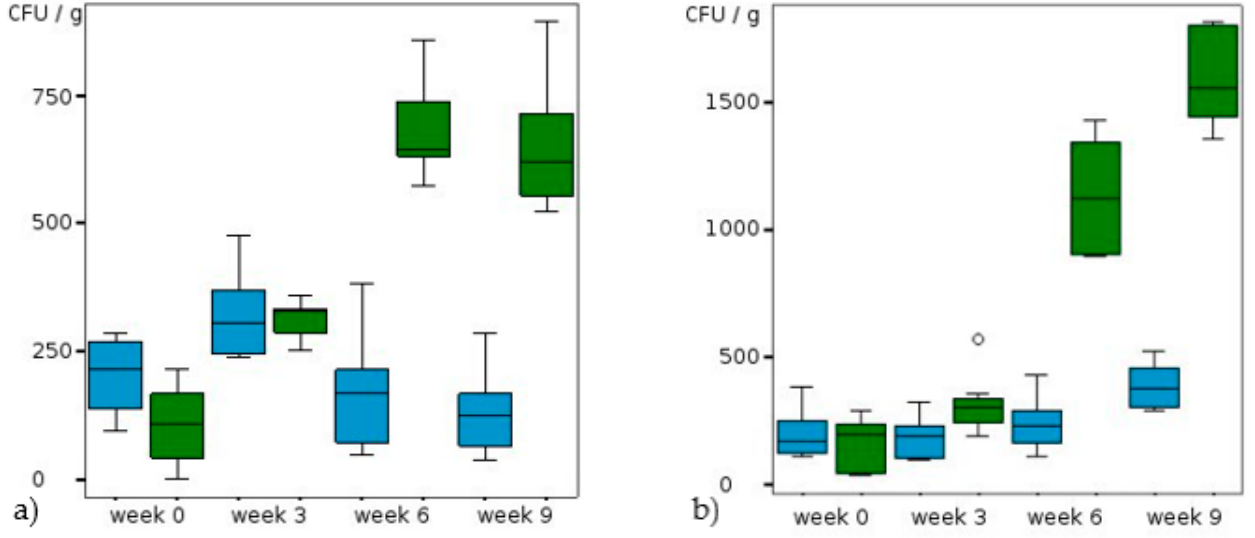
Figure 3. Alteration of CFU/g soil (dw) at ( a ) 18 ◦ C and ( b ) 25 ◦ C and different diesel concentrations (blue: 5 g/kg soil, green: 10 g/kg soil, circles: outliers). The isolated Scedosporium strains represented four species: S. apiospermum , S.